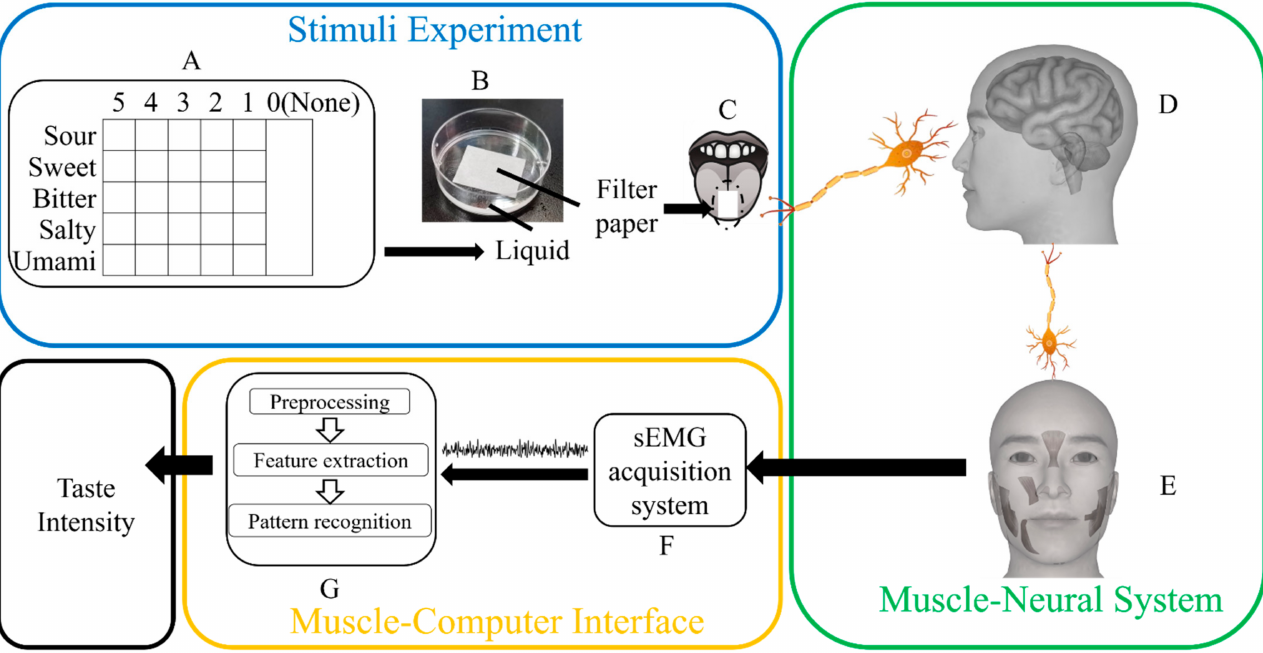
Figure 1. Schematic diagram of the study. Twenty-six types of solutions (including deionized water) were prepared ( A ). The filter paper was soaked in a type of solution for each trial ( B ). Then, the filter paper was put on the subject’s tongue ( C ). The signal of taste sensation was transported to the central neural system ( D ). Driven by the central neural system, the muscles were activated ( E ). An acquisition system recorded the sEMG of these muscles ( F ). The taste intensities were quantified based on acquired signals, after signal preprocessing, feature extraction, and pattern recognition ( G